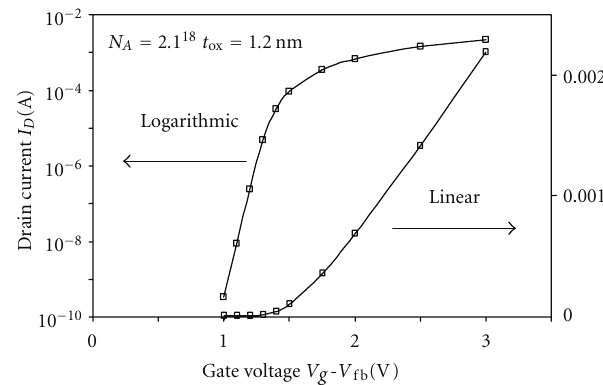
Figure 11: Transfer characteristics I D 11 ( Vg ) in logarithm and linear scales. V S = 0; V D = 2V. ( L = 90nm; W/L =